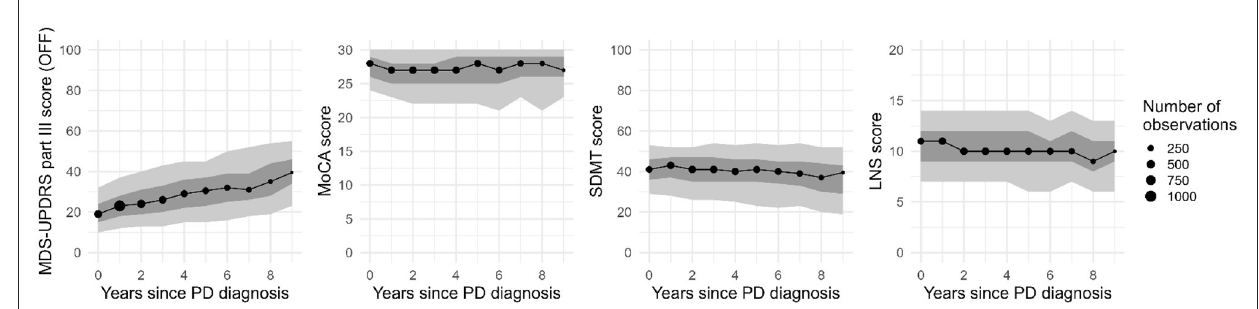
FIGURE2 Progression of the outcome measures on the group level for the PD cohort from the PPMI study (median, 30th and 70th percentiles in dark gray, and 10th and 90th percentiles in light gray; missing values were excluded). Only years with at least 30 assessments are shown. MDS-UPDRS, Movement Disorders Society Unified Parkinson Disease Rating Scale; MoCA, Montreal Cognitive Assessment; SDMT, Symbol Digit Modalities Test; LNS, Letter-Number Sequencing task.